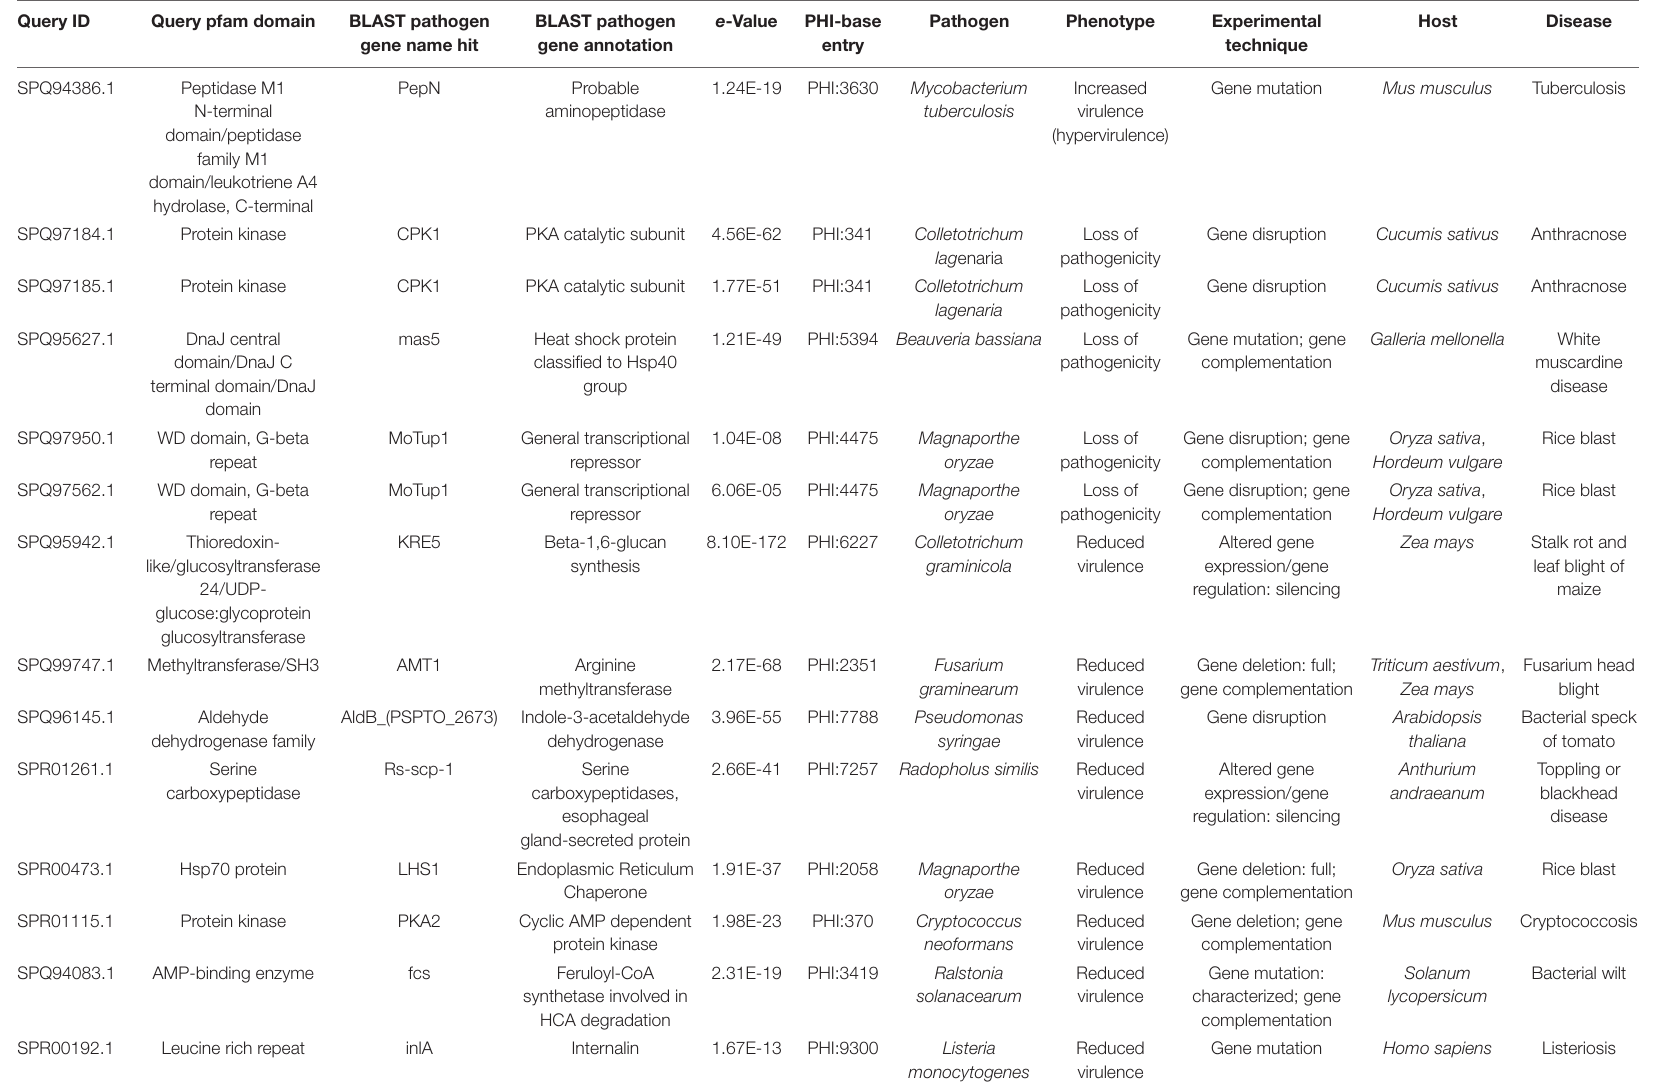
TABLE 2 | Pathogen–host interactions (PHI)-base matches of non-redundant P. brassicae secreted protein transcripts, organized by phenotype after gene mutation/alteration. Query